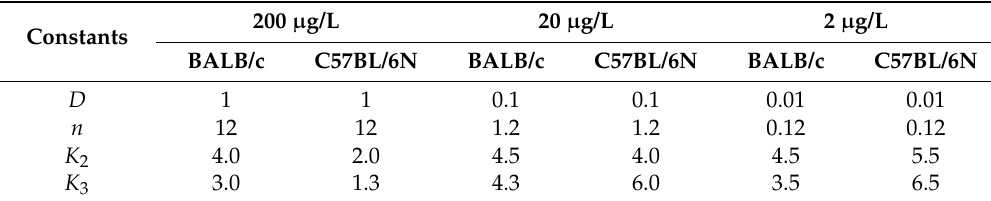
Table 2. Calculated constants for three tested estradiol concentrations and two inbreed mouse strains, where D is dilution factor, n is molar ratio, and K 2 and K 3 are overall rate constants. 200 µ g/L 20 µ g/L 2 µ g/L Constants BALB/c C57BL/6N BALB/c C57BL/6N BALB/c C57BL/6N D 0.1